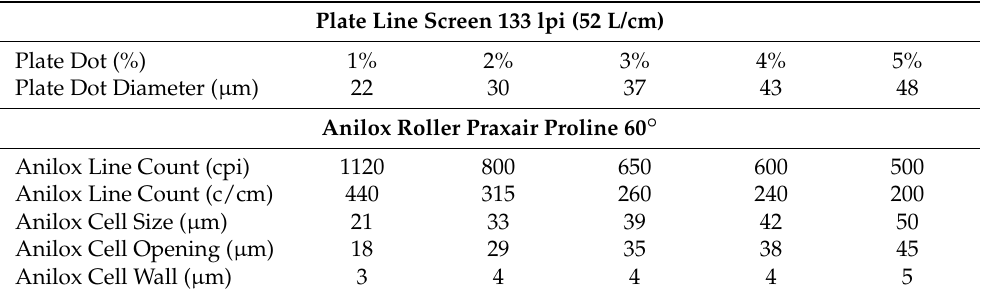
Table 3. Proper ratio between the anilox line count and the plate dot size for dot coverages from 1% to